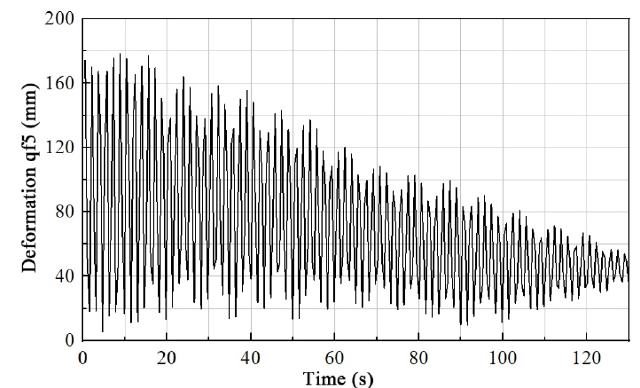
Figure 10. Lateral 1/4 Circumferential Deformation of the Top Node (Group #4) .